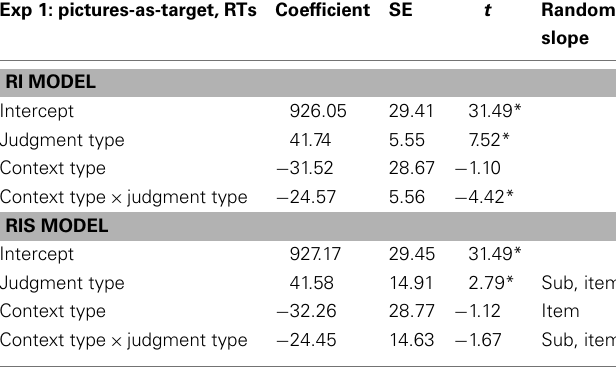
Table 1 |The linear mixed-effects regression models on the reaction times for the (picture)